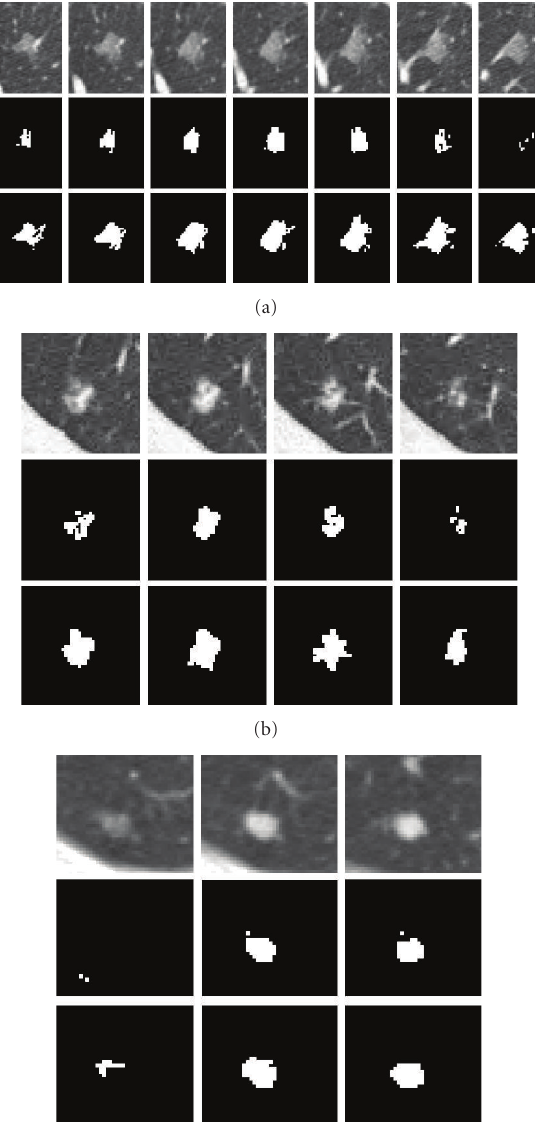
Figure 17: Dice coe ffi cients based on the two di ff erent methods for all the solid